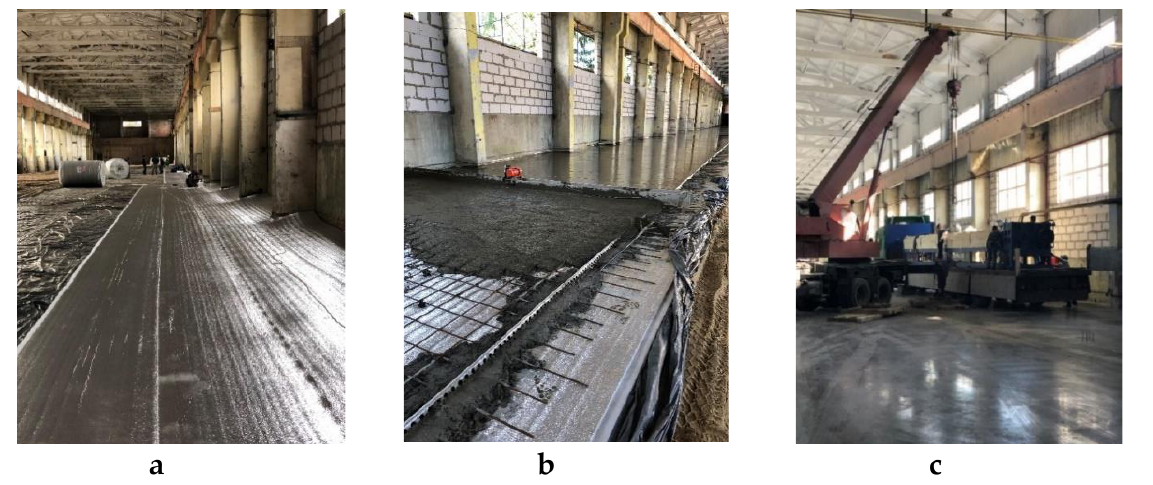
Figure 7. Installation of a floating floor in an industrial building: ( a ) — laying of rolled polyethylene foam on the prepared base and formation of a seamless shell; ( b ) — installation of reinforcement frames and pouring of concrete; ( c ) — installation of heavy equipment on the industrial floor.